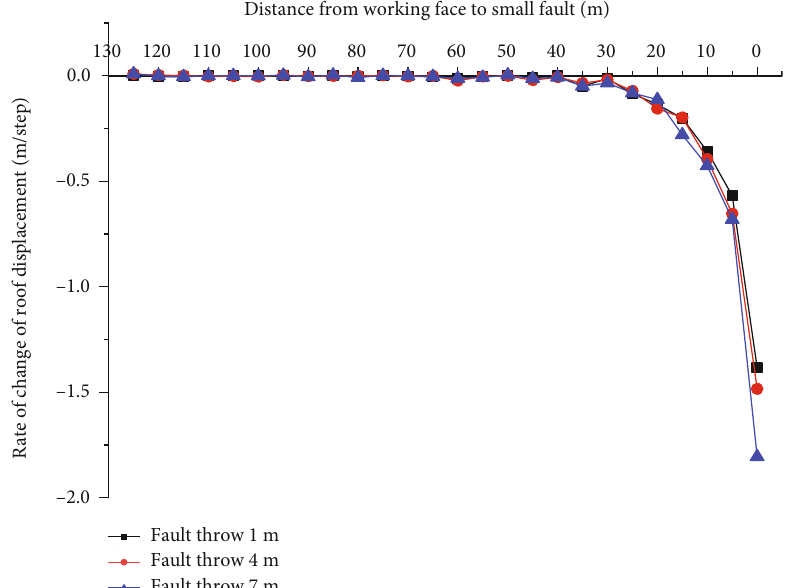
Figure 7: Rate curve of monitored points. The black dotted line represents a fault throw of 1 m, the red dotted line represents a fault throw of 4m, and the blue dotted line represents a fault.